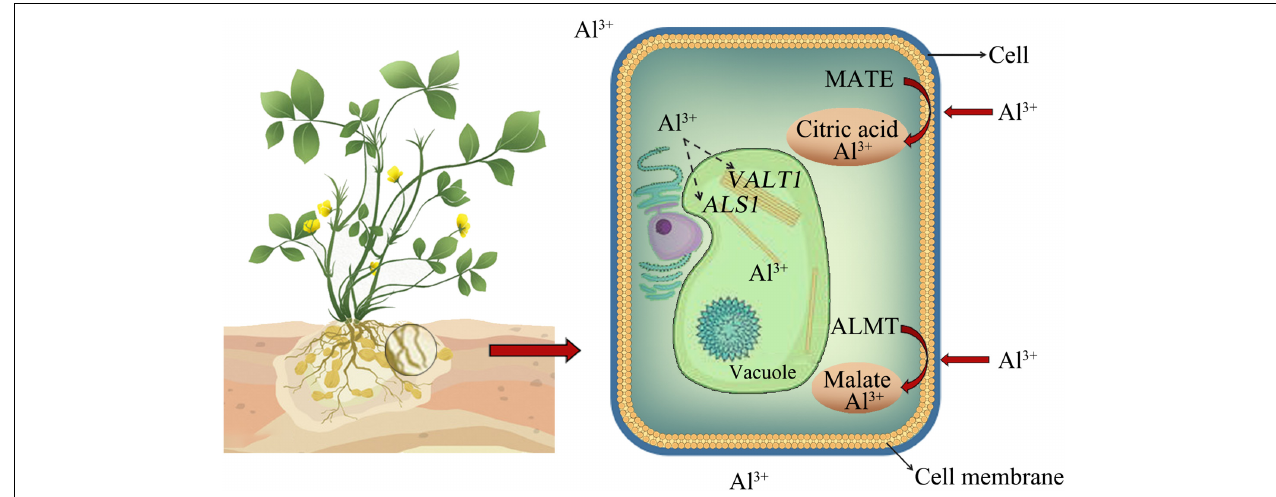
FIGURE 1 | External rejection mechanism of aluminum (Al) and internal tolerance mechanism. Organic acids could chelate Al3+ into non-toxic compounds, thereby preventing them from entering root cells. MATE regulates the secretion of citric acid, and ALMT regulates the secretion of malate to chelate Al3+. Al3+ entering the cytoplasm might be transported into the vacuole through the regulation of ALS1 or VALT1 genes (Zhang X. et al.,